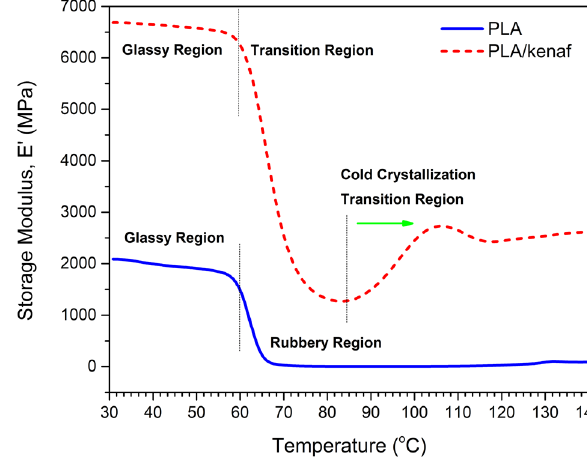
Figure 3: TGA curves for PLA matrix, kenaf fi bers, and PLA – kenaf